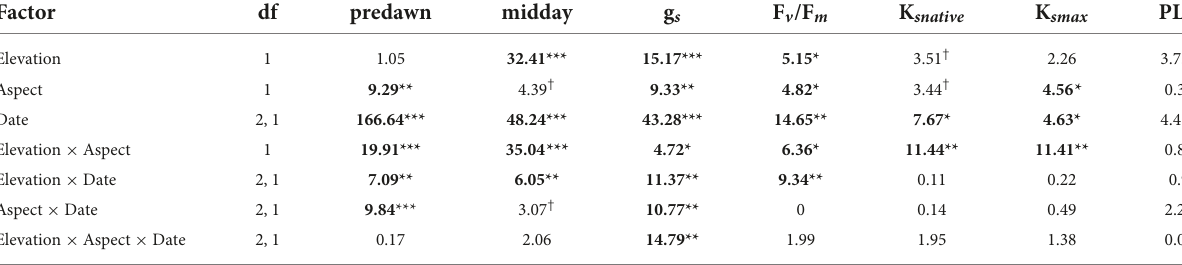
TABLE 2 Summary of results from repeated-measures ANOVAs for ecophysiological variables.